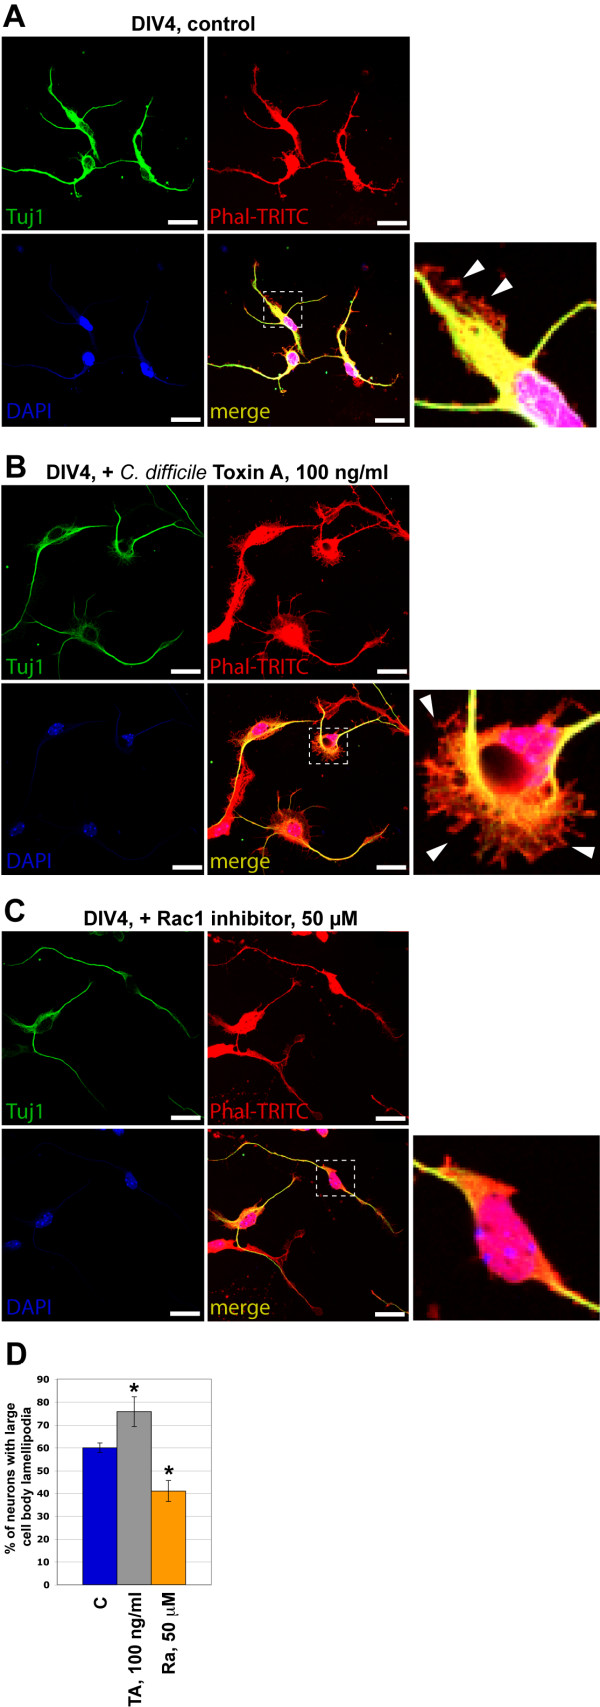
Analysis of small GTPase involvement in lamellipodia formation of SVZ/RMS-derived neurons. Lamellipodia outgrowth analysis in control (A) cultures and in cultures after C. difficile Toxin A and Rac1 inhibitor treatment (B) and (C), respectively. Arrowheads in insets mark large lamellipodia. Cultured cells were treated with inhibitors and the amount of neurons having large lamellipodia on cell body and major cell processes was calculated at DIV4. (D) While Rac1 inhibitor significantly decreased the number of neurons with large lamellipodia, Toxin A increased it (* - p < 0.001). Abbreviations: Phal-TRITC - phalloidin-TRITC complex to label F-actin, Ra - Rac1 inhibitor, TA - Rho GTPases inhibitor Toxin A of C. difficile, Tuj1 - tubulin beta III to label immature neurons. Scale bars are 20 μm.